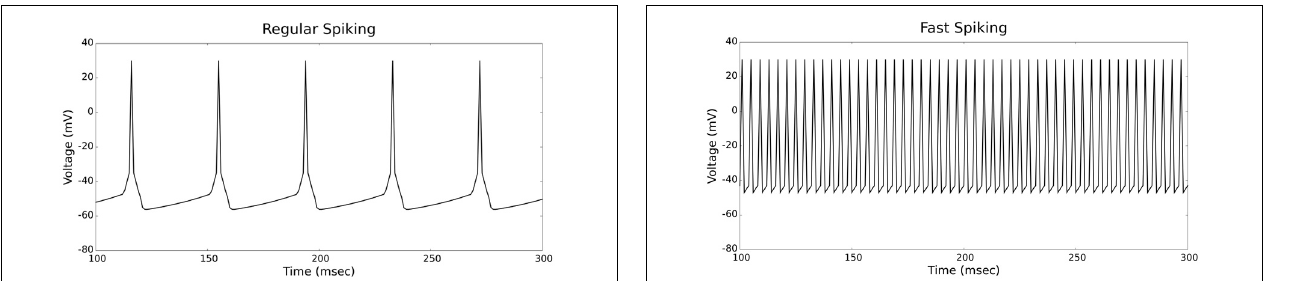
FIGURE 4 | LIF neuron model: regular spiking firing patterns.